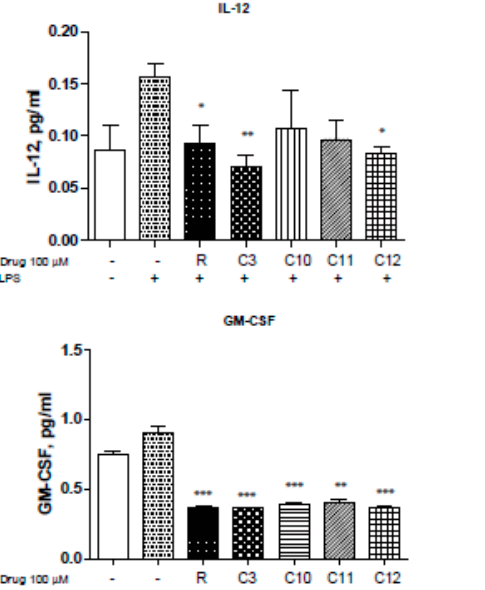
Figure 3. Resveratrol and derivatives reduce cytokine production in human colon cancer cell line HCT-116. Cytokine and chemokine levels were differentially reduced with resveratrol and derivatives. Briefly, HCT-116 cells were allowed to grow in 6-well plates to 60% confluency, treated with drugs (100 µM) for 24 h, and then stimulated with LPS (1.5 mg/mL) for 4 h. The supernatant (500 µL) was collected and sent to Eve technologies (https://www.evetechnologies.com/technology.php). N = 3. * p -value < 0.05, ** p -value < 0.01, and *** p -value < 0.001. If not stated, p -value > 0.05.